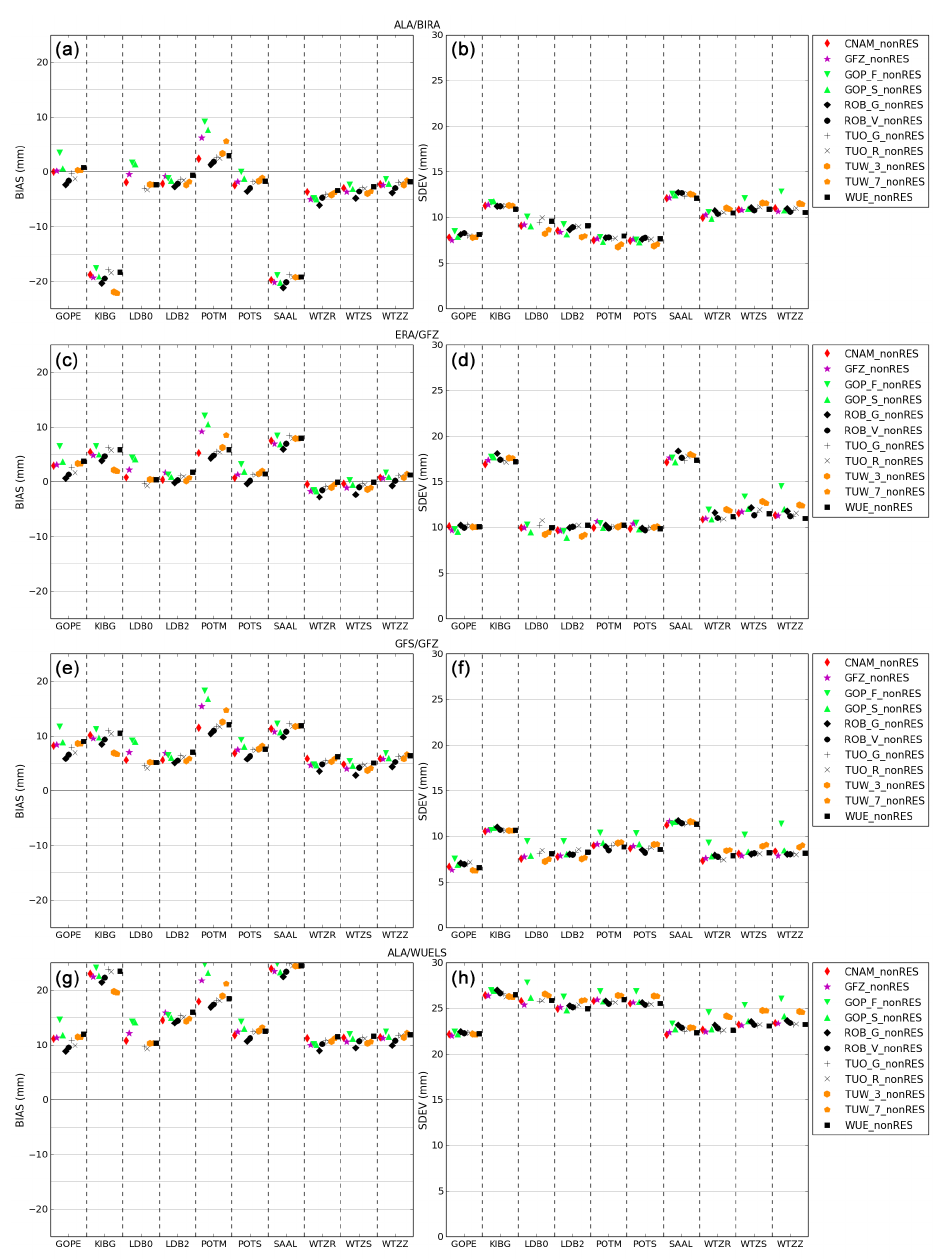
Figure 8. Comparison of individual GNSS STD solutions without residuals (nonRES) against NWM solutions ALA/BIRA, ERA/GFZ, GFS/GFZ and ALA/WUELS (from top to bottom), projected in the zenith direction: bias (a, c, e, g) and standard deviation (b, d, f, h)